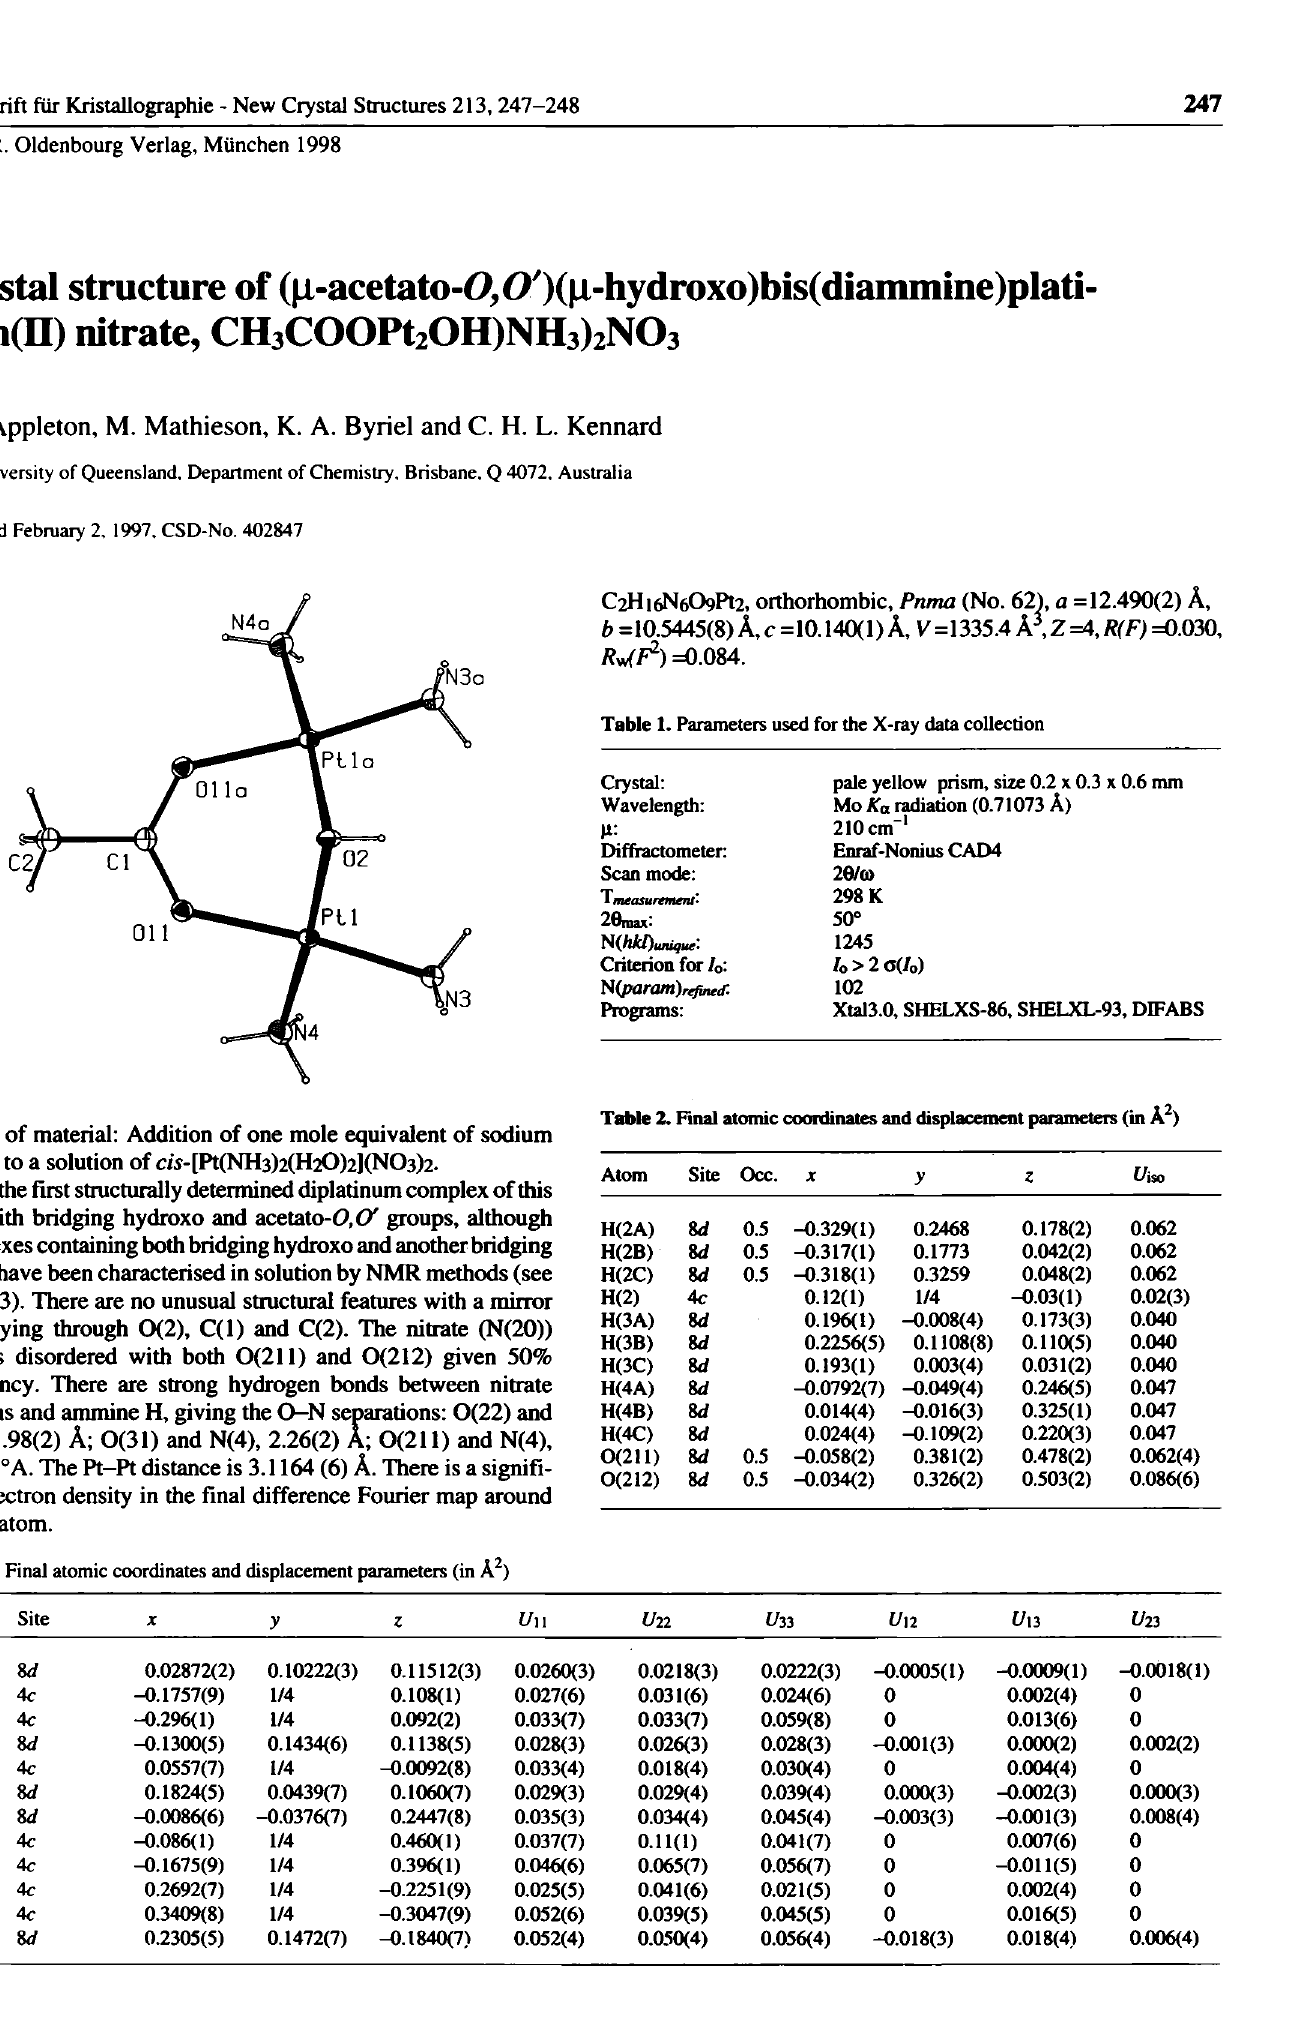
Table 3. Final atomic coordinates and displacement parameters (in Â^)